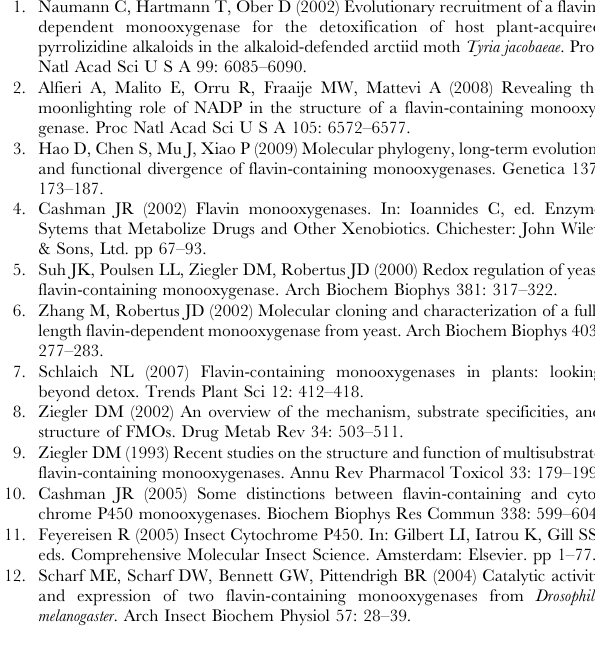
Table S2 PCR-based strategy for identification of partial FMO- like sequences of various lepidopteren species.